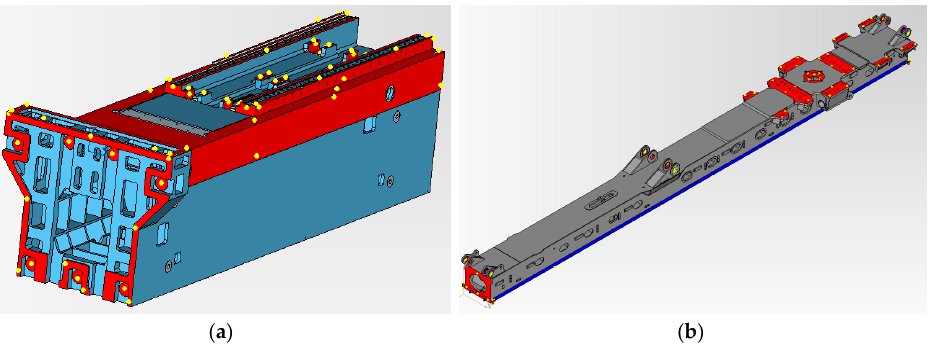
Figure 17. Fitting of measured non-coded targets (yellow) to the nominal part geometry, corresponding to the industrial examples (( a ) Soraluce milling machine travelling column, and ( b ) Liebherr drilling rig lead center), where optimal target coordinates are given in the ideal part frame for an even overstock distribution in all surfaces to be machined (red).